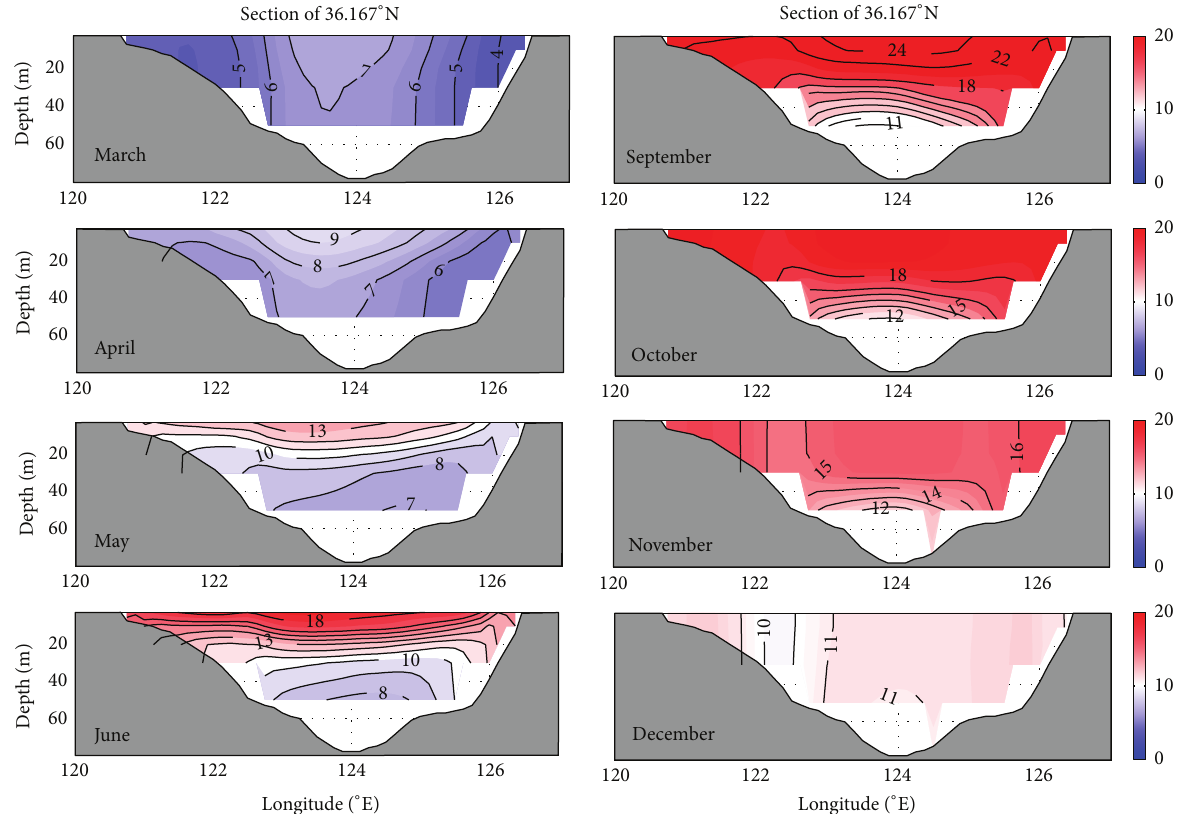
Figure 3: Vertical cross sections of monthly mean temperature ( ∘ C) along 36.17 ∘ N and 38.667 ∘ N for the locations indicated in Figure